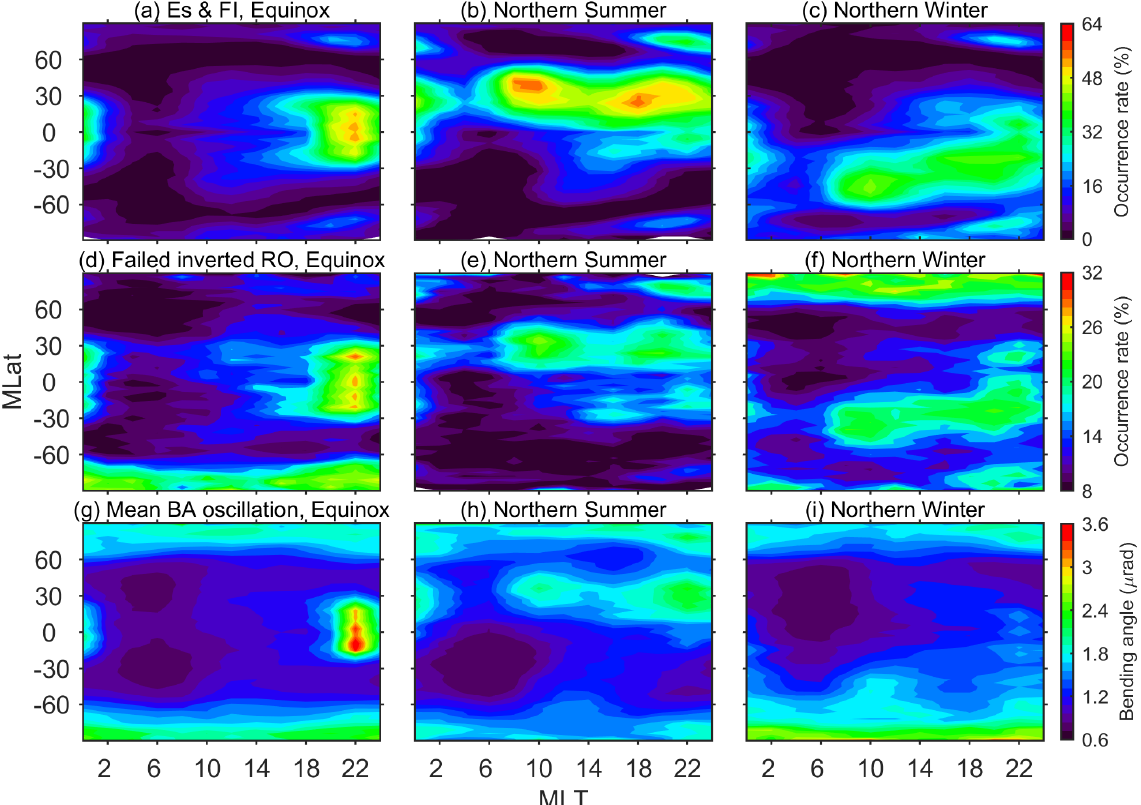
Figure 7. The same as Fig. 6, but for geomagnetic local time (MLT) and geomagnetic latitude (MLat)